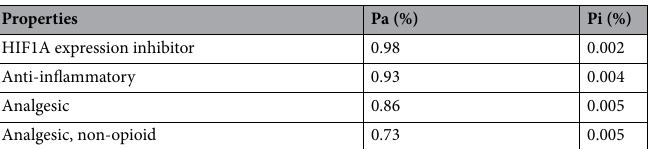
Table 8. Pharmacological properties of 15K obtained through in silico PASS prediction, and the properties on which 15K showed more than 70% probability to be active are presented here. HIF1A Hypoxia-inducible factor 1-alpha, Pa Probability to be active, Pi Probability to be inactive.